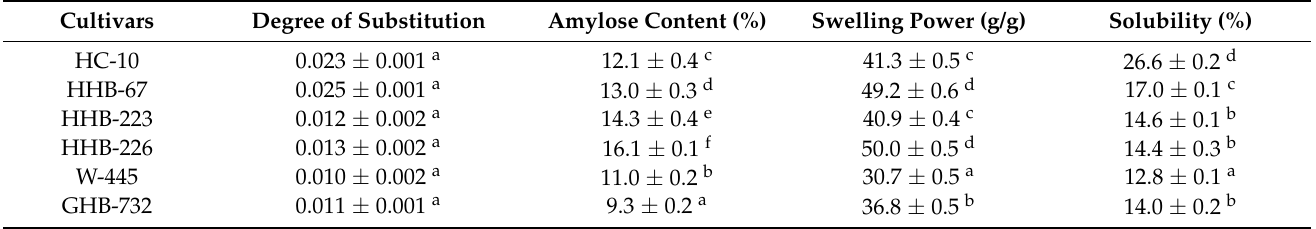
Table 1. Degreeofsubstitution(DS),amylosecontent,swellingpowerandsolubilityofOSA-modified